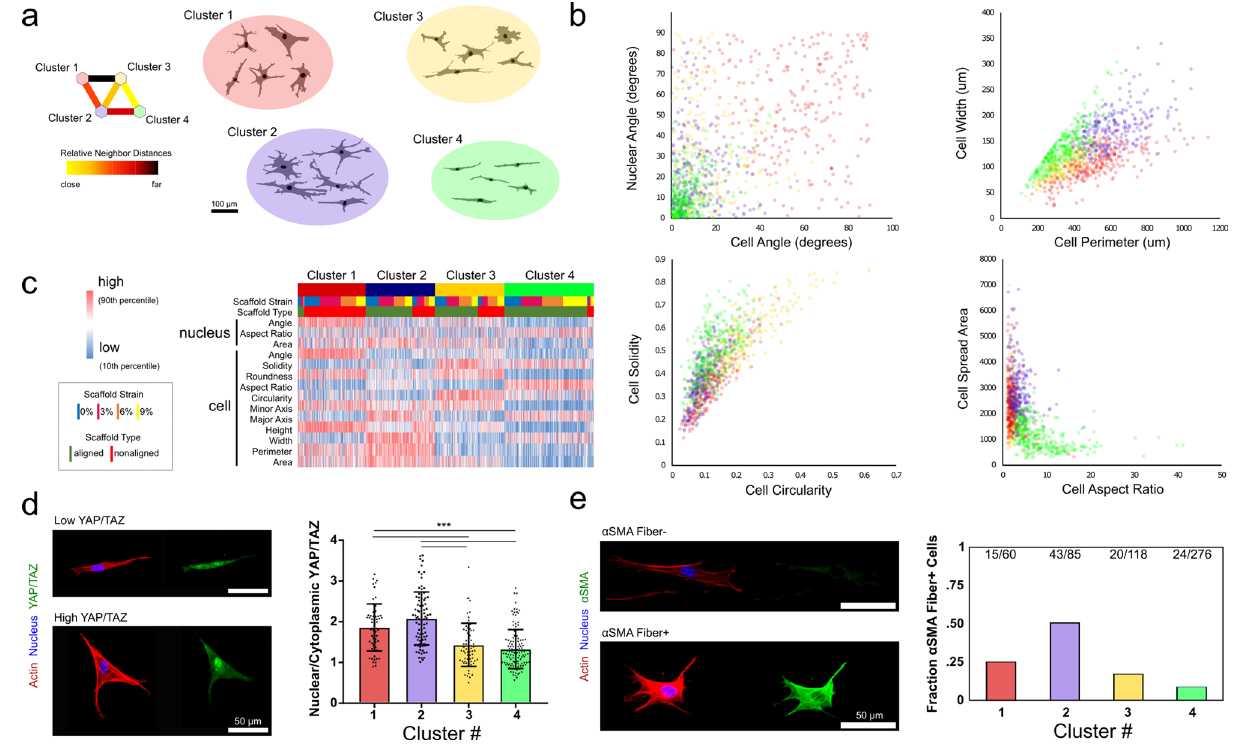
Figure 1. Dimensionality reduction predicts relationship between cell morphology and mechanosensing in engineered fiber environments. ( a ) Images of cells were segmented and 14 cell and nuclear morphology parameters were collected for each. These data were simplified via a neural-network-based self-organizing map approach to dimensional reduction that identified four shape groups. ( b ) The distinction between groups is highlighted by relationships between cell and nuclear descriptors of size, shape, and orientation. ( c ) Shape clusters were related to both baseline fiber organization and degree of stretch-mediated reorganization. ( d ) YAP/TAZ imaging on a subset of cells revealed a connection between shape clusters and mechano-sensing, as indicated by nuclear/cytoplasmic levels of YAP/TAZ. ( e ) These same clusters also represented different propensities of adopting a pro-fibrotic α-smooth muscle actin + phenotype (numbers denote number of cells identified as being αSMA stress fiber + over total cells identified in that cluster). (*** denotes p < 0.001, n =